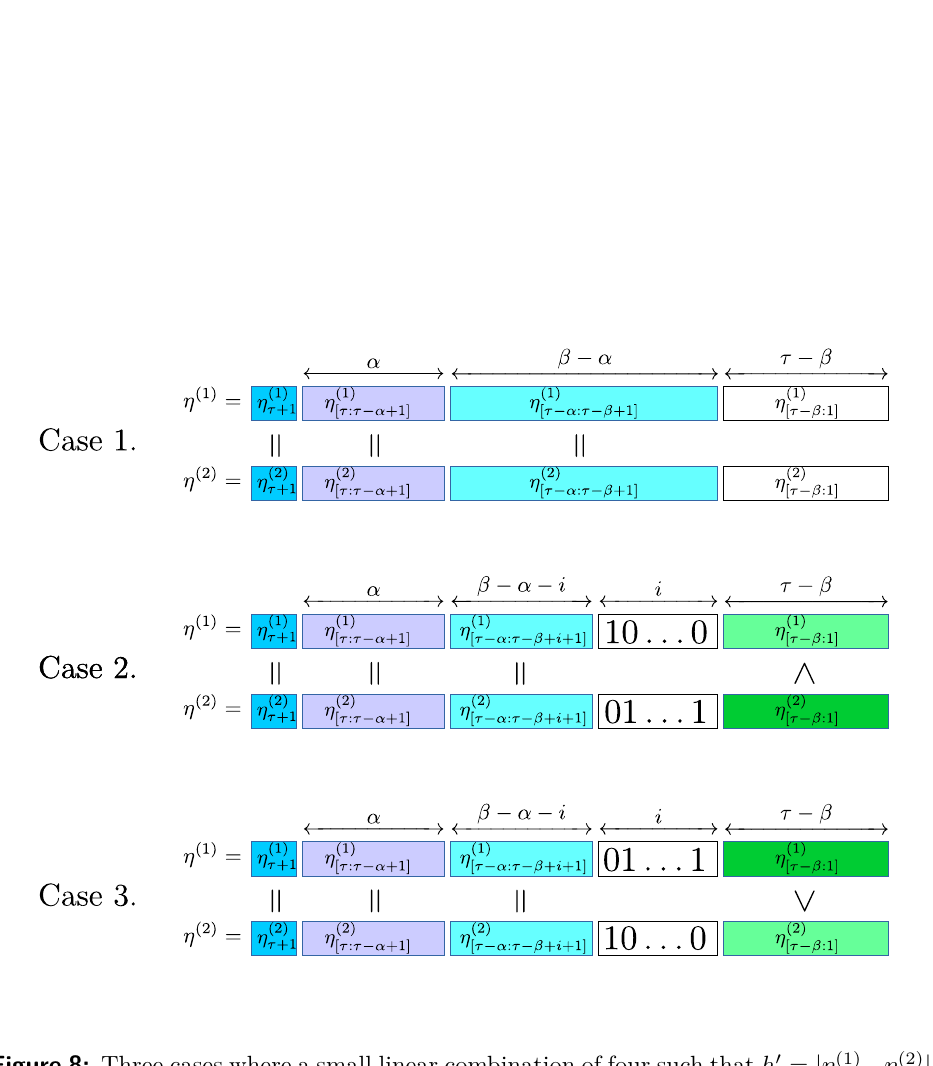
Figure 8: Three cases where a small linear combination of four such that h 0 = | η (1) − η (2) | < 2 τ − β is found in Algorithm